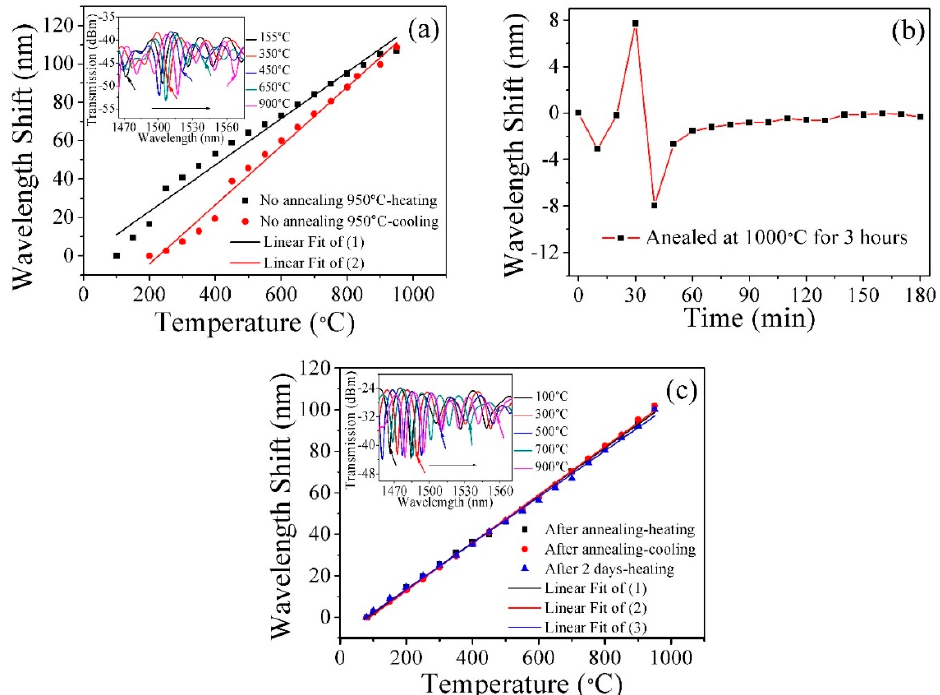
Figure 5. Wavelength shift versus temperature for the MZI-based sensor (L = 3 cm): ( a ) Wavelength shift of a sensor with no-annealing process. ( b ) The corresponding stability test in 3 h before and after the annealing process at 1000 ◦ C. ( c ) The same dip was chosen for annealing processes and in the inset an example of the temperature shifting of the sensor after annealing at 1000 ◦ C for 3